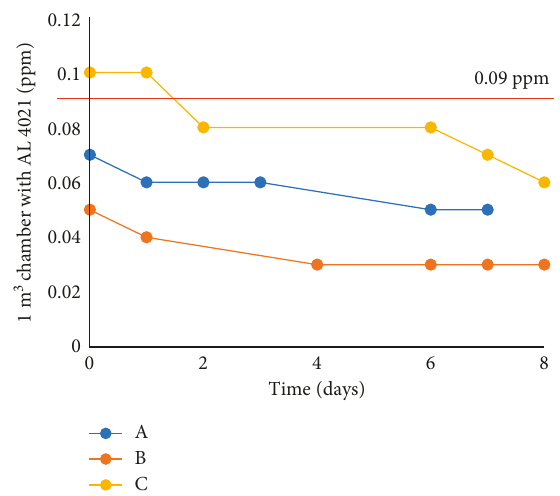
Figure 7: Formaldehyde emission (measured with the 1 m 3 chamber using the Aero-laser AL4021) reduction with time (days) after the production for the particleboard types A (standard), B (standard low-emission), and C (low-density). Day 0 is after 2 h conditioning from the production. The EPA TSCA Title VI level of 0.09 ppm for particleboards is marked in the